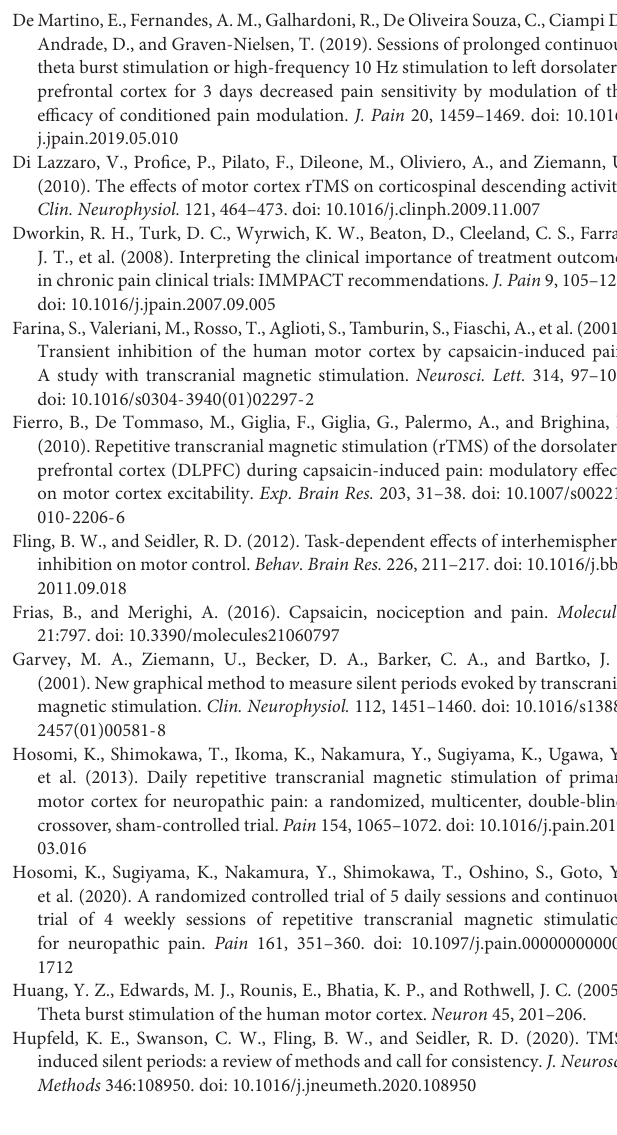
Supplementary Figure 1 | Results of all samples and variances. (A) Shows the samples and variances of the averaged pain ratings within each phase. Similarly, S0- and S20-pcTBS decreased pain in the stabilizing (all P corrected < 0.05) and descending (all P corrected < 0.05) stages compared to the Sham stimulation. (B) Indicates the samples and variances of analgesic efficacy of S0- and S20-pcTBS. S0-pcTBS resulted in a larger pain reduction in the descending phase compared to the S20-pcTBS as well as that in the stabilizing phase. (C) Shows the samples and variances of MEP. Pain inhibited MEP in all stages compared to the baseline (all P corrected < 0.05) in the Sham condition, while pcTBS at S0 reversed depressed MEP in the stabilizing ( P corrected = 0.022) and descending stages ( P corrected = 0.024), as well as a trend increase in the ascending phase ( P corrected = 0.06). (D) Shows the samples and variances of pcTBS on CSP. CSP duration was increased by the S20-pcTBS in the stabilizing ( P corrected = 0.033) and descending (all P corrected = 0.015) stages compared to the Sham